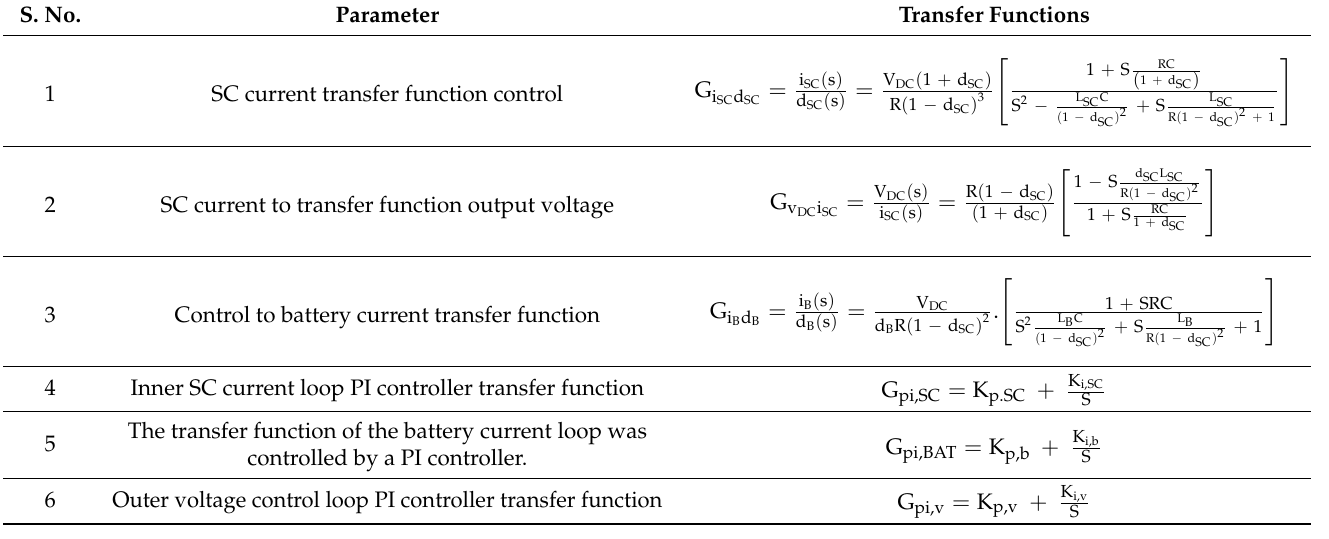
Table 4. Linear averaged transfer functions for small signals.